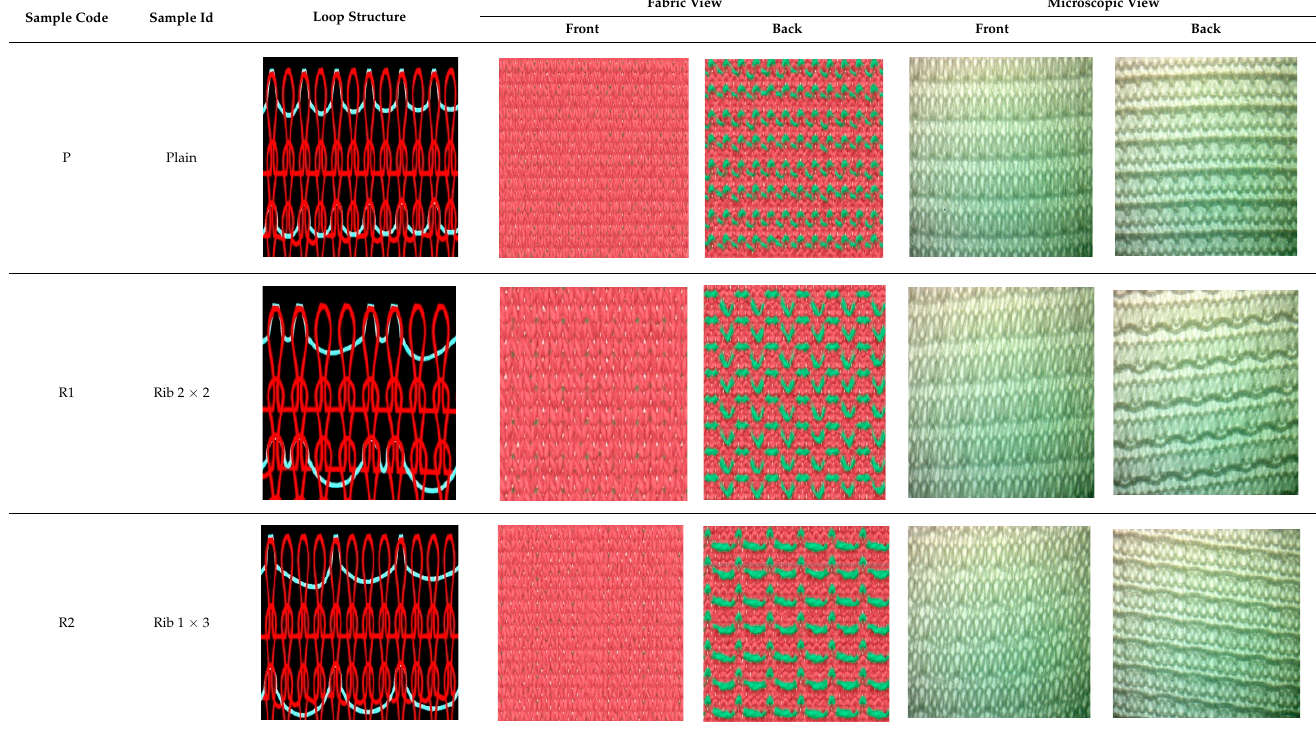
Table 3. Structural representation and systematic diagrams of the developed samples.